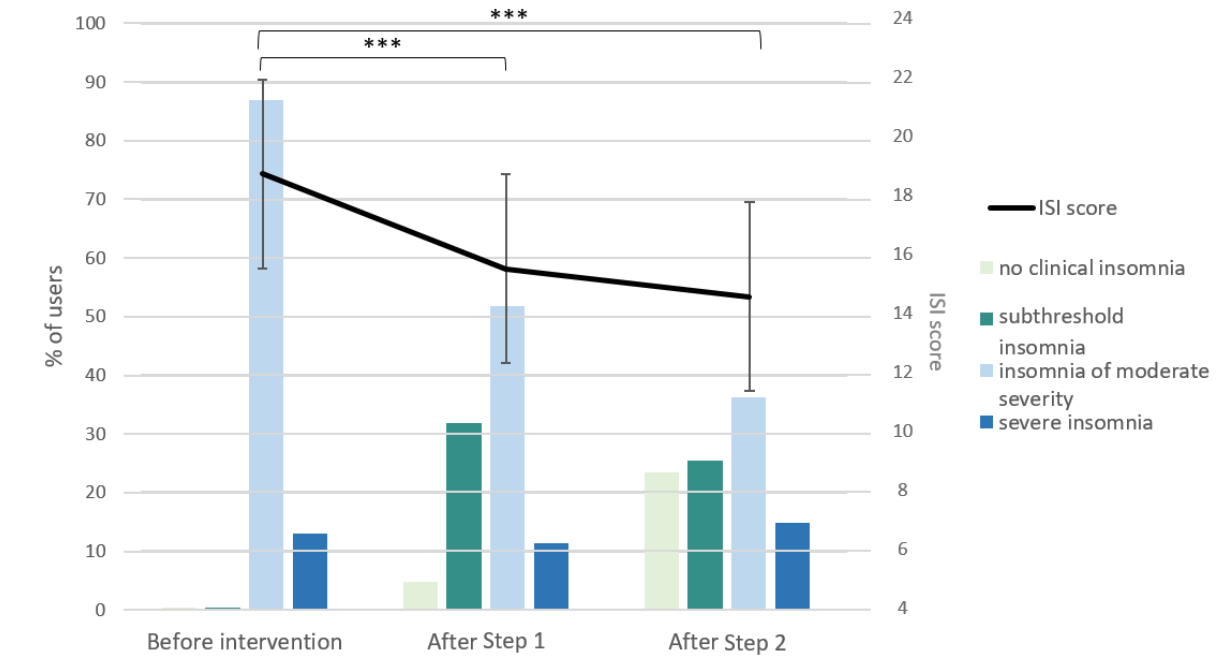
Figure 5. Distribution of users depending on the severity of their insomnia complaints (based on ISI scores) along the intervention program: Step 1: